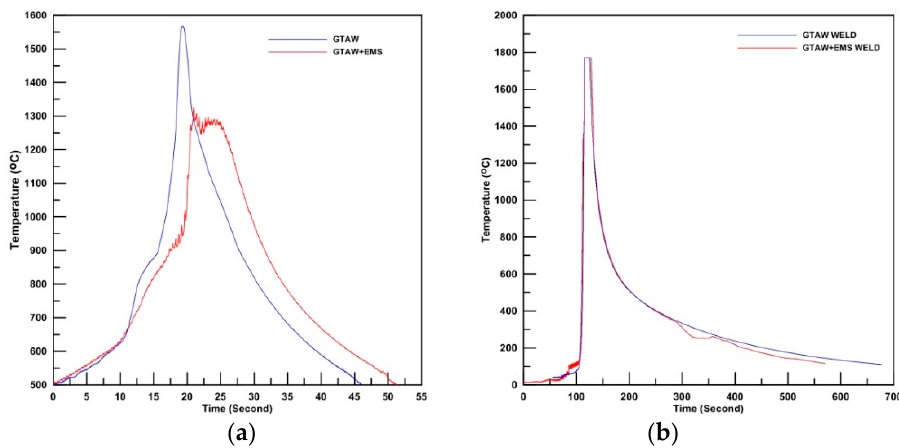
Figure 4. The temperature profiles by the bead-on-plate tests: ( a ) the HAZ, and ( b ) the weld.